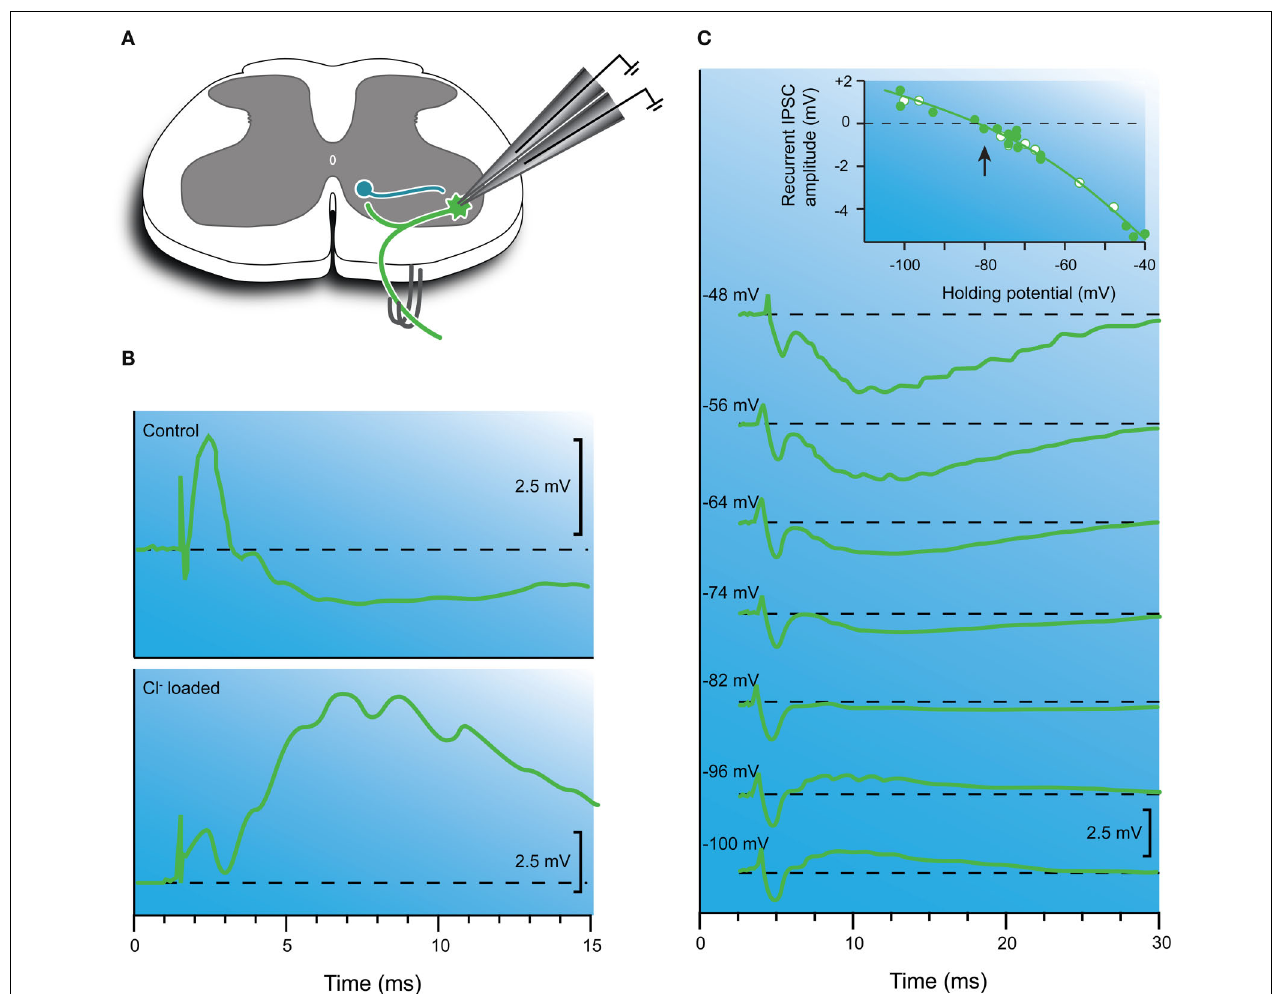
double-barreled intracellular microelectrode (dashed line equals baseline). One barrel recorded membrane potential and the other was used to inject current and control/hold membrane potential. In these experiments a NaSO internal 4 solution was used to avoid chloride loading (as shown in B ). Note the polarity of the response varies with holding potential. The inset shows a plot of the recurrent IPSC amplitude vs. holding potential. The IPSP reversed at − 80 mV, which approximates the equilibrium potential for chloride ions in CNS neurons. Modifi ed with permission from Figures 1, 2 and 4 in Eccles et al.